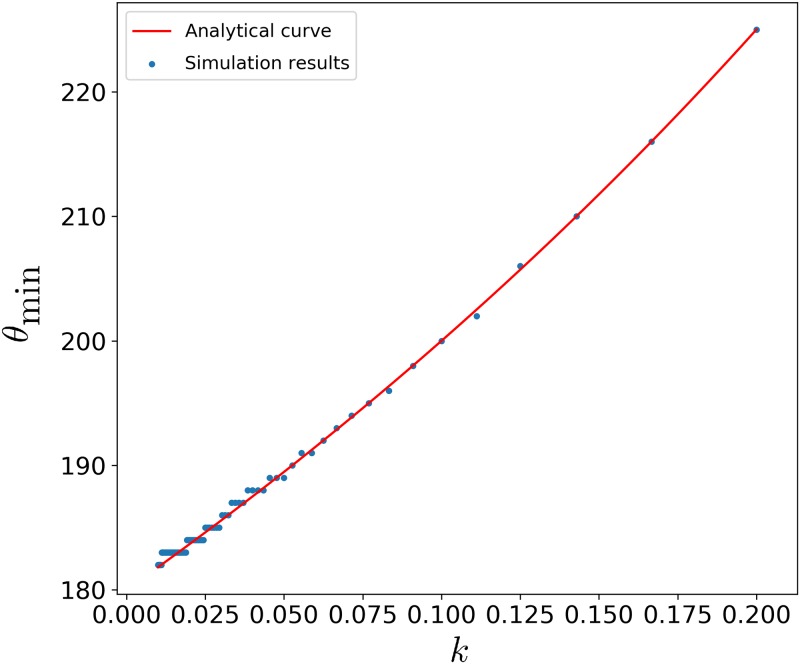
Graph of θmin versus k.